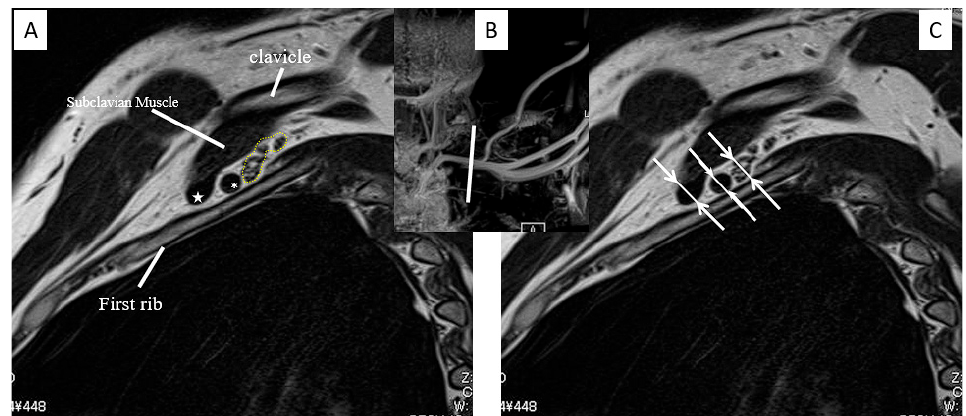
Figure 4. Left sagittal view. ( A ) The SCV (star), SCA (asterisk), and nerve bundle (dot line) are shown. ( B ) Scout view of MRI-MIP image. ( C ) SCA, SCV, and nerve bundle diameter measurements (arrows). MRI-MIP, magnetic resonance imaging maximum-intensity projection; SCA, subclavian artery; SCV, subclavian vein.